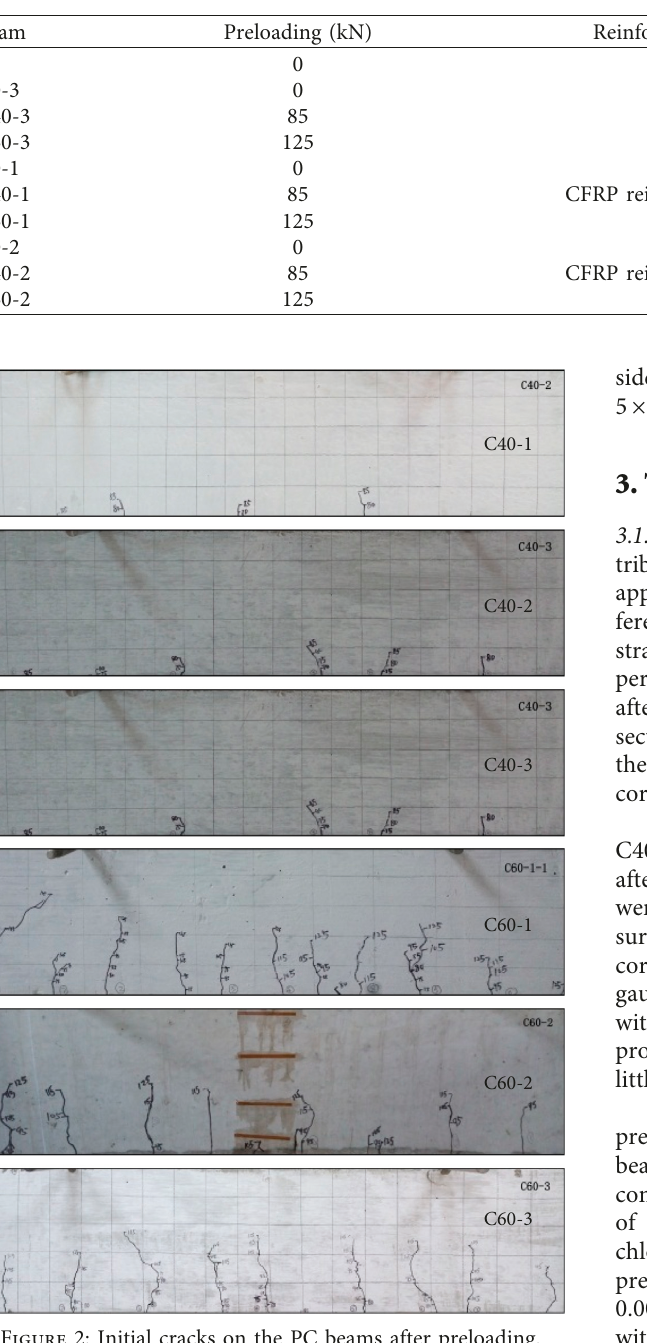
Figure 1: Beam details (unit: mm). Table 1: Test conditions.